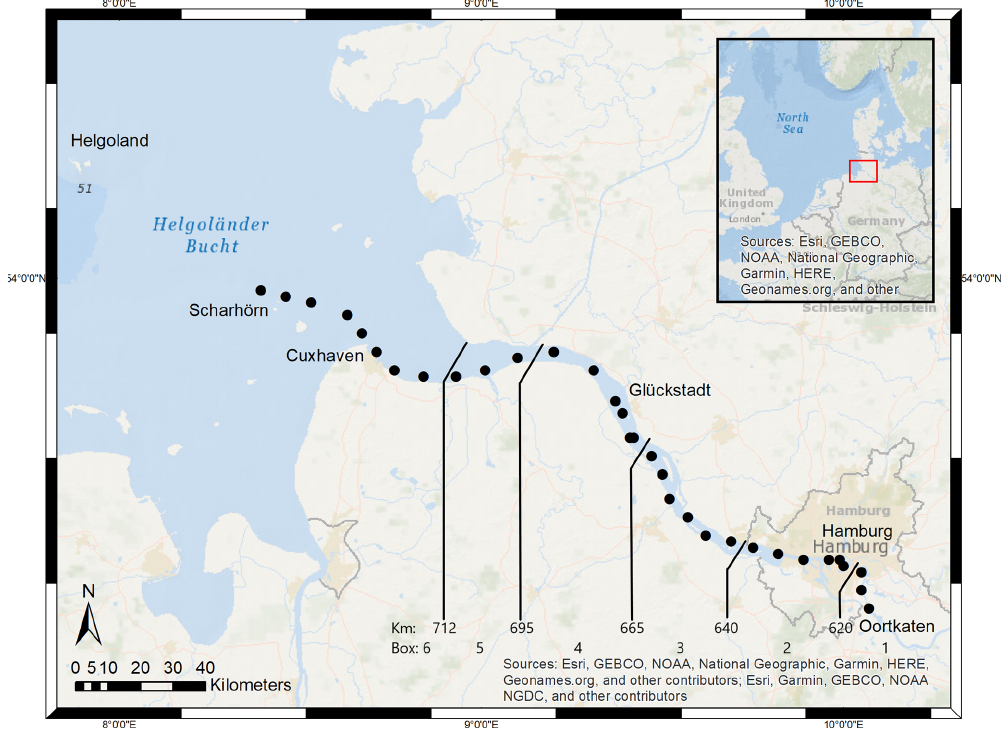
Figure 1. Study site. The Elbe Estuary with sampling stations in June 2019 (dots) and the spatial separation of the estuary for the mass balance calculation (lines), whereby box 2 indicates the port of Hamburg in the upper estuary, box 3 and box 4 the middle estuary, and box 5 the lower